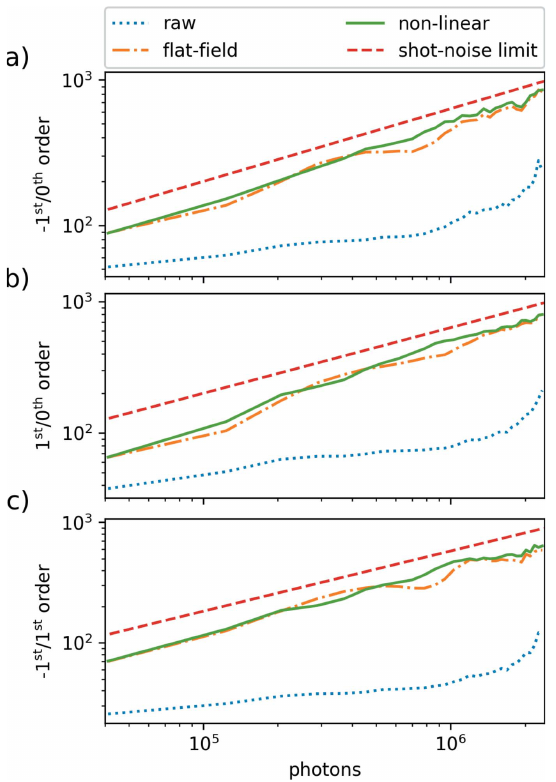
Figure 7 SNR (inverse of the standard deviation) of the data binned as a function of the intensity in the 0th order for ( a ) the (cid:2) 1st/0th order, ( b ) the +1st/0th order and ( c ) the (cid:2) 1st/+1st order. Data that are only dark-corrected are shown as dotted blue lines. Data that are also flat-field corrected are shown as dot-dashed orange lines. Data that are also corrected for non- linearity are shown as continuous green lines. The photon shot-noise limit is shown as dashed red